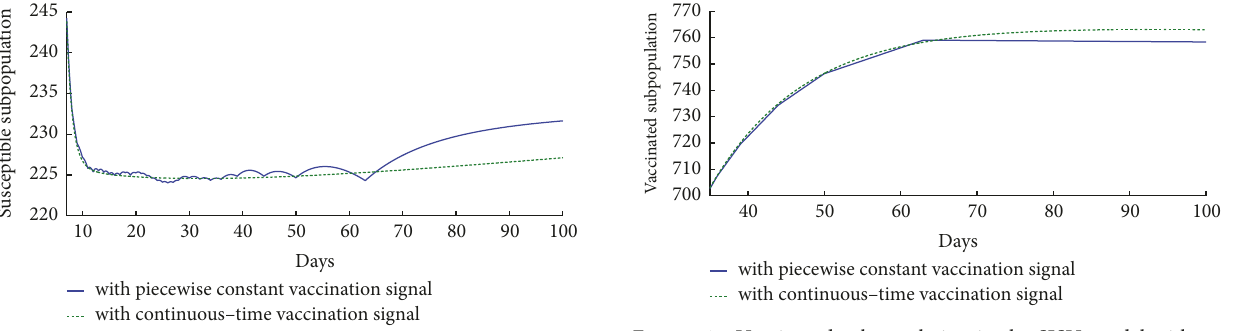
Figure 13: Susceptible subpopulation in the SISV model with two different vaccination signals: (i) piecewise constant signal taking integer values and (ii) continuous-time signal.